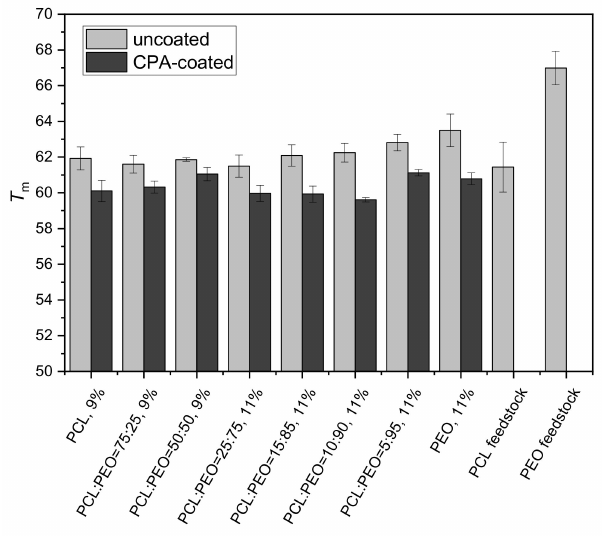
Figure 2. Melting temperature ( T m ) obtained from the DSC thermographs of uncoated and CPA-coated PCL / PEO electrospun mats during the first heating cycle. The PCL / PEO ratio and polymer weight concentration in the electrospinning solution are given on the